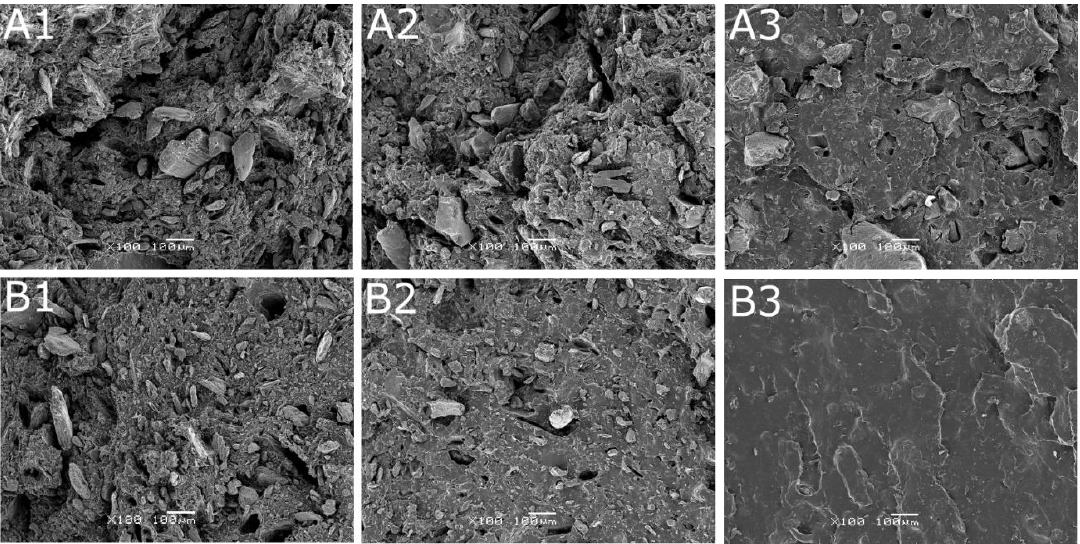
Figure 6. SEM images of samples: ( A1 ) NR / BSG100 S , ( A2 ) NR / BSG / GTR50 / 50 S , ( A3 ) NR / GTR100 S , ( B1 ) NR / BSG100 P , ( B2 ) NR / BSG / GTR50 / 50 P , ( B3 ) NR / GTR100 P (magnification ×